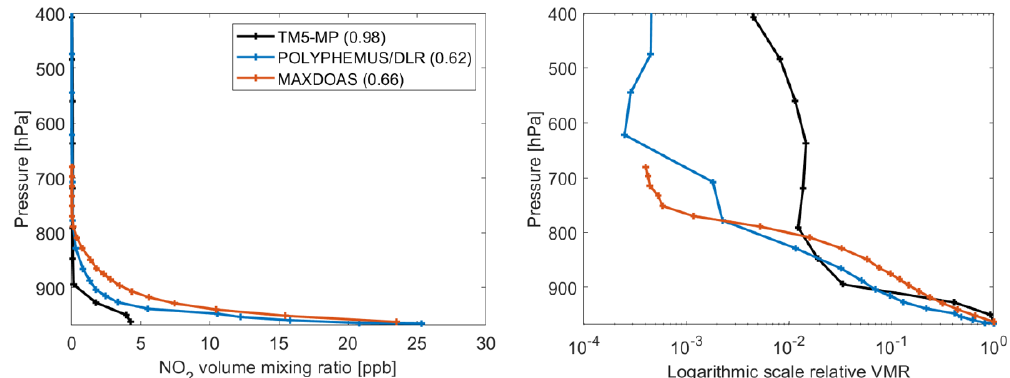
Figure 9. A priori NO 2 profiles from the chemistry transport models TM5-MP and POLYPHEMUS/DLR and the low-tropospheric NO 2 profile derived from the ground-based MAX-DOAS measurements over Munich in Germany (48.15 ◦ N, 11.57 ◦ E) on 5 February 2019. The calculated clear-sky tropospheric AMF is given in brackets next to each label in the legend. Normalized profiles (to the lowest values) are also shown on a logarithmic